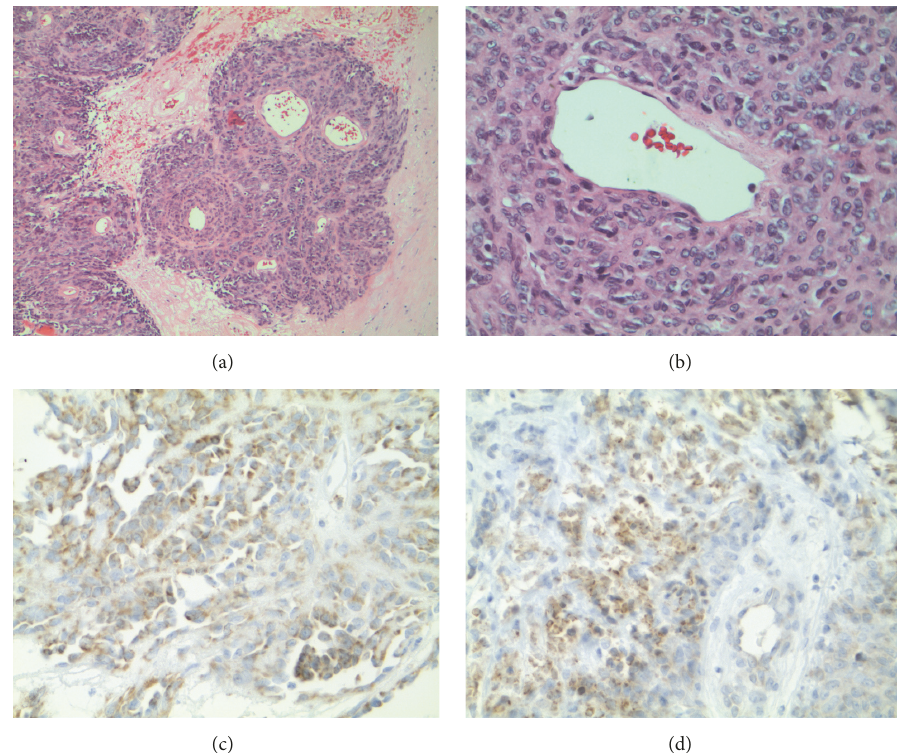
Figure 3: Histology and immunochemistry of malignant PEComa. (a) Malignant cells in a concentric arrangement around blood vessels (H&E, 100x). (b) Epithelioid cells with granular light eosinophilic cytoplasm and oval nuclei with small nucleoli (H&E, 400x). (c) Melan-A demonstrates salient cytoplasmic immunoreactivity, supporting melanocytic phenotype (Melan-A (MART-1), 400x). (d) HMB-45 demonstrates salient cytoplasmic immunoreactivity, supporting melanocytic phenotype (HMB-45, 400x).